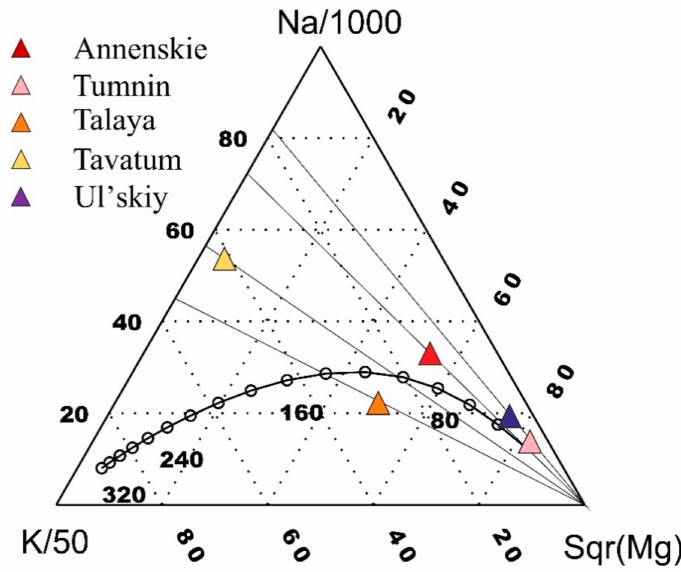
Figure 4. Content of K, Na and Mg in thermal waters of the Okhotsk Sea